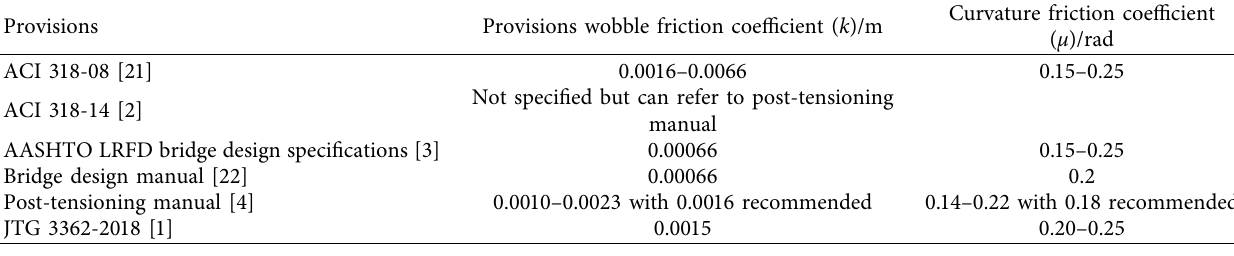
Table 1: Recommended friction